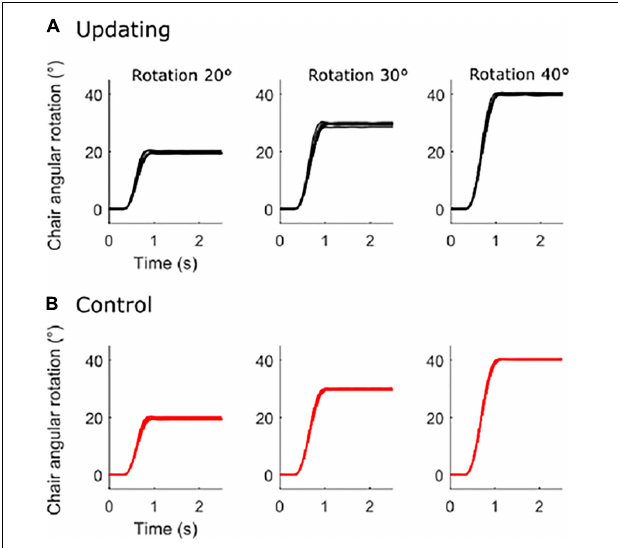
FIGURE 1 | Chair angular rotation. Mean time-series of each participant for the updating condition (A) and for the control condition (B) for the 20 ◦ (left), 30 ◦ (middle), and 40 ◦ (right) rotation